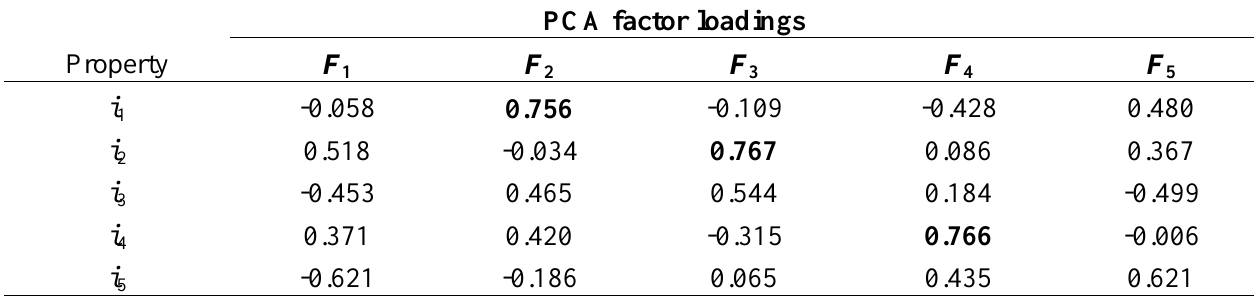
Table 5. Principal component analysis loadings for the vector property of local anaesthetics. a PCA factor loadings Property